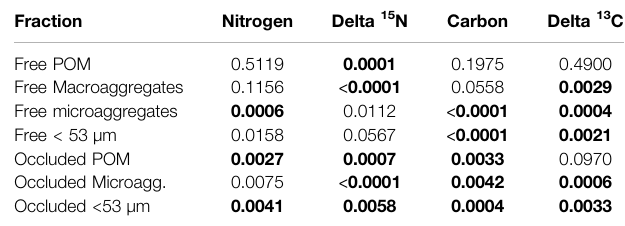
TABLE 4 | Distribution of macroaggregate soil in three occluded fractions (occluded) from nine sites investigated in this study. Occluded POM (%)